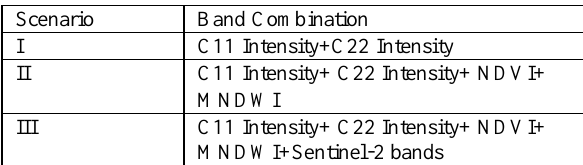
Table 2. Scenarios applied for classification over ROI-2.